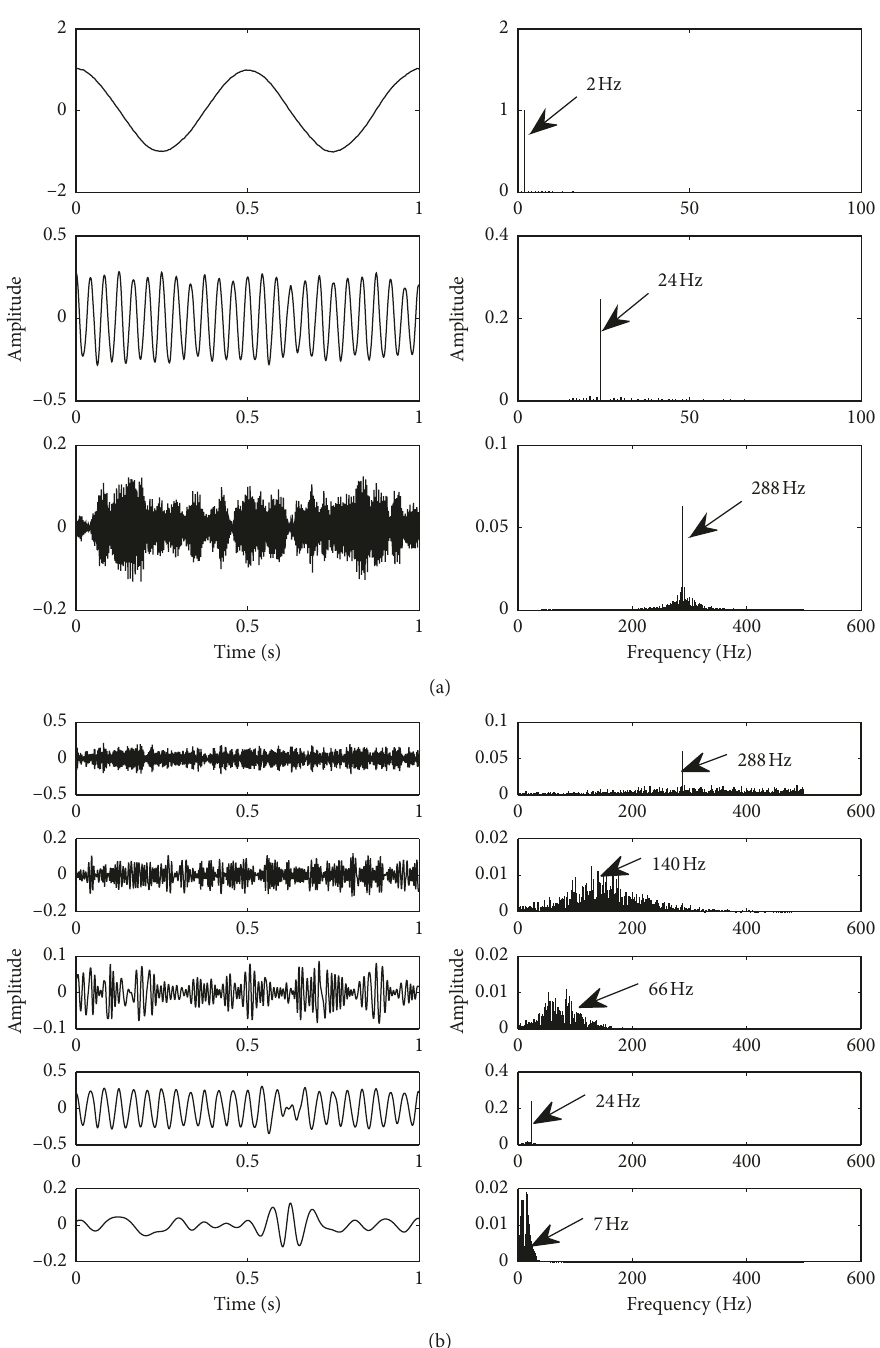
Figure 2: Signal decomposition comparison: (a) waveforms and spectrums of VMD; (b) waveforms and spectrums of